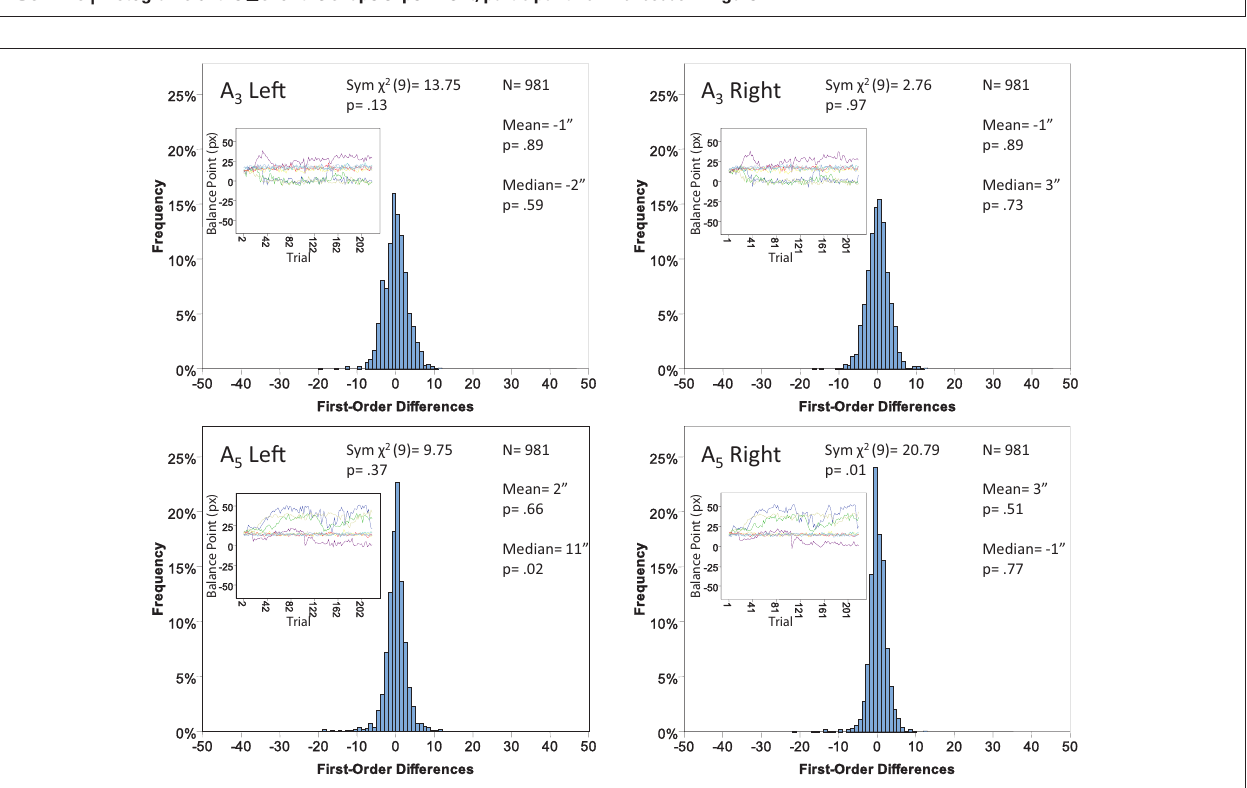
Figure 13 | Histograms of the ∆ ’s for the shape experiment, participant P5. The rest as in Figure 7.